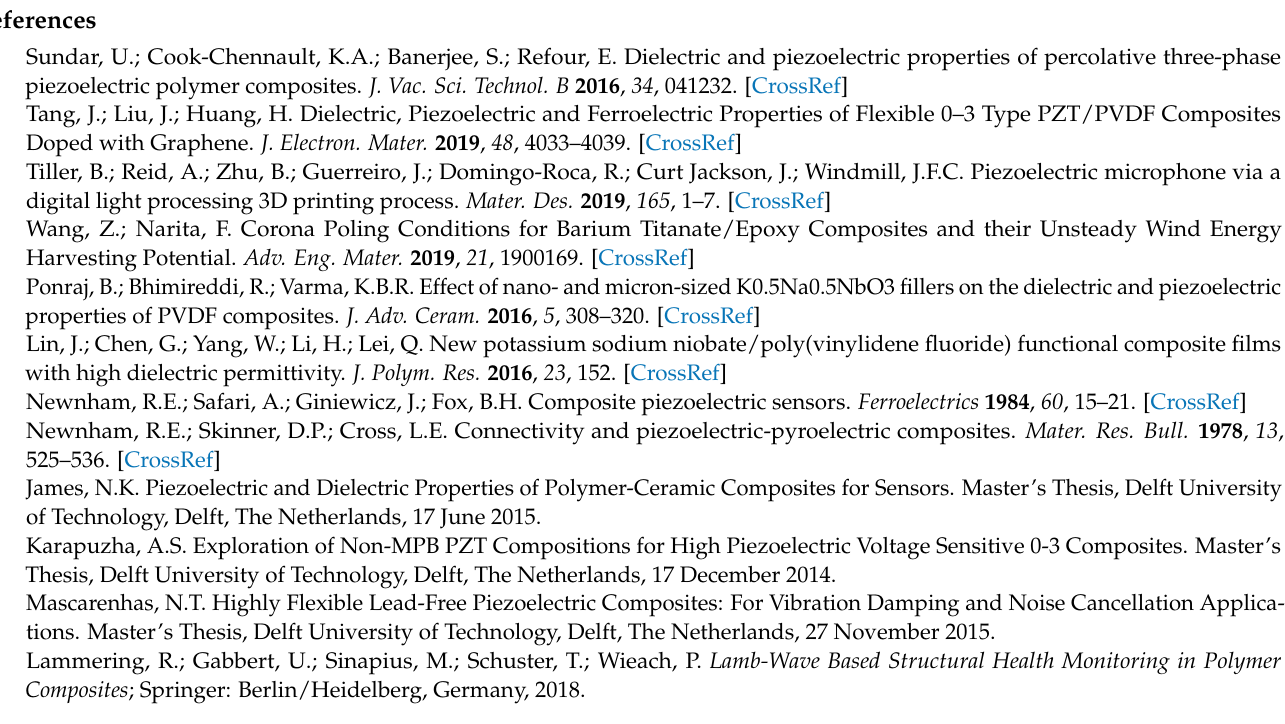
Figure S1: SEM images of piezoelectric ceramics used in this study; Table S1. Properties of piezo- electric ceramics; Figure S2. X-ray diffraction pattern at room temperature of ceramics used in this study; Table S2. Properties of nanofillers; Figures S3–S6: SEM images of nanofillers used in this study; Figure S7. Schematics of UV light curable suspension preparation; Figure S8. Process of UV light curable suspension preparation; Figure S9. Schematic representation of piezoelectric composite sensor forming and solidification; Figure S10. Tape-casting of piezoelectric composite sensors; Figure S11. Principle of measurement of dielectric properties without applied electrodes; Figures S12–S28: SEM images of cross-sections of investigated composites; Table S3. Properties of piezoelectric composites with measurement errors. References [122–125] are cited in the Supplementary